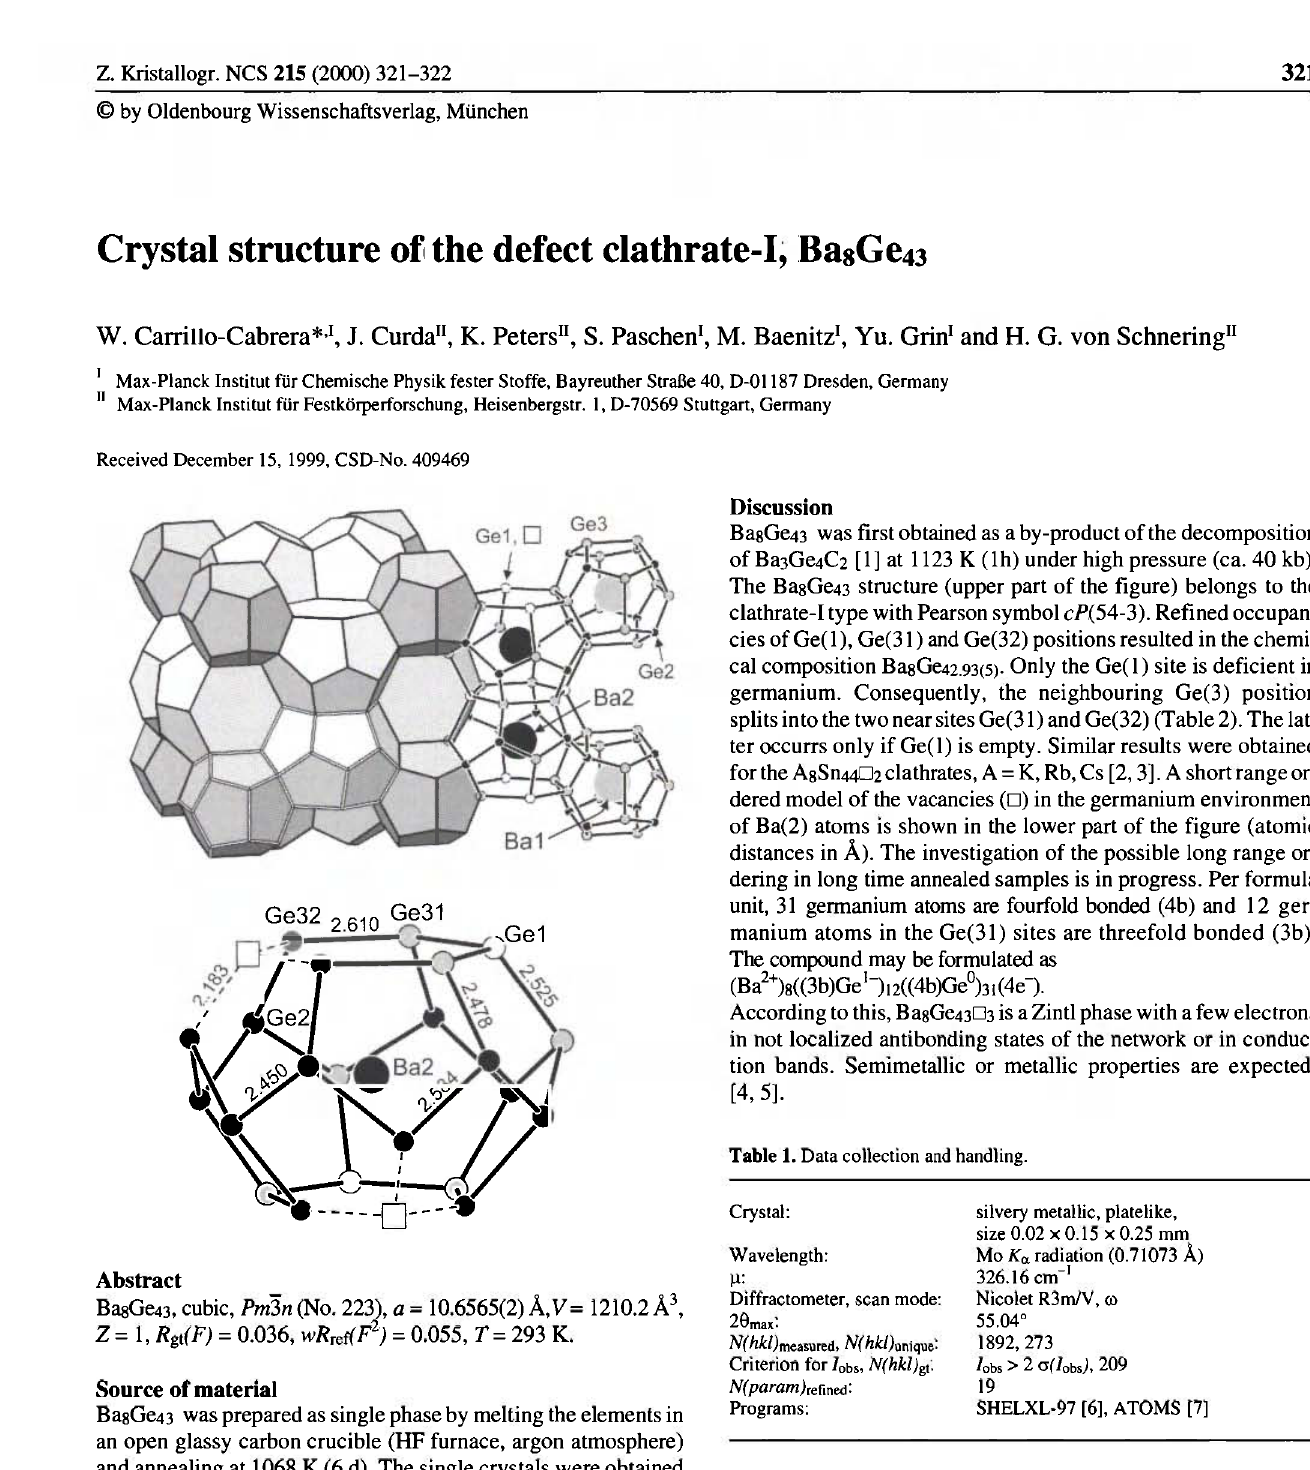
Table 1. Data collection and handling.